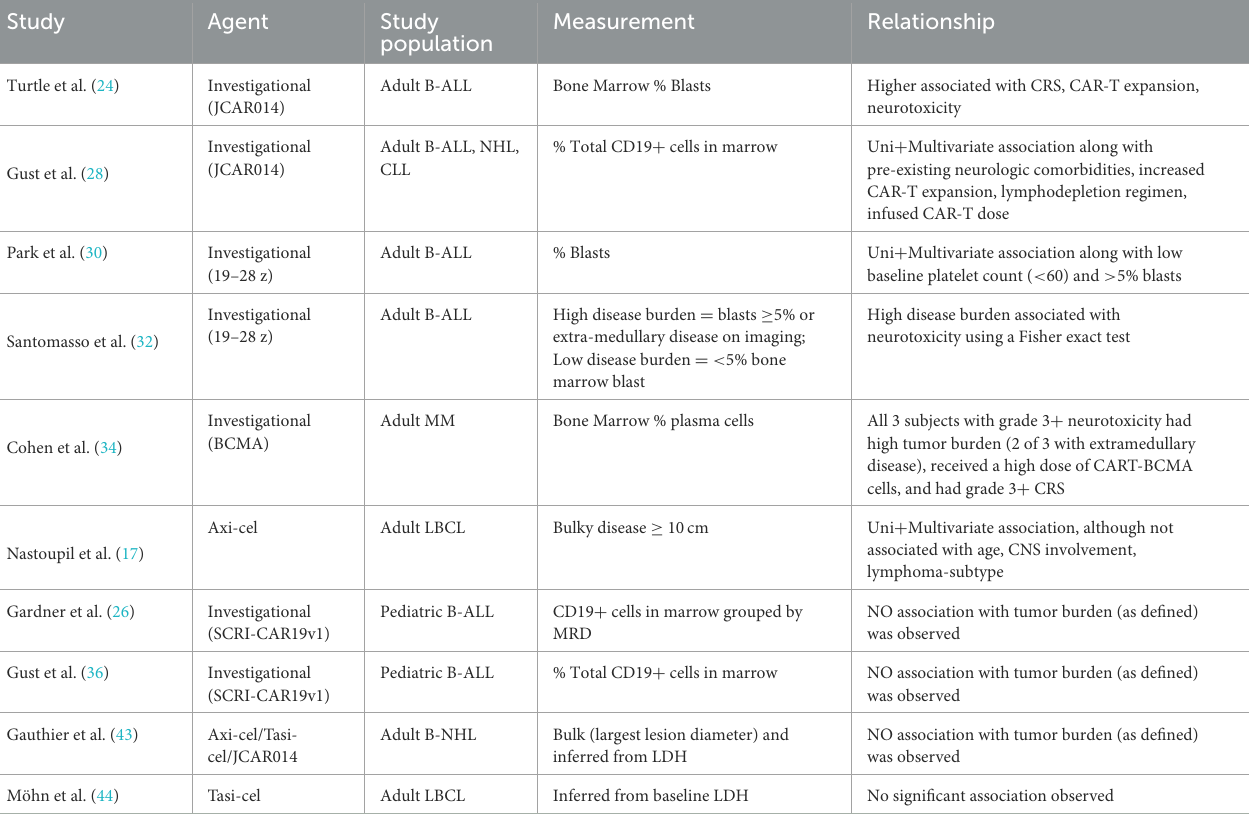
Measurement Relationship population Higher associated with CRS, CAR-T expansion, neurotoxicity Uni + Multivariate association along with pre-existing neurologic comorbidities, increased CAR-T expansion, lymphodepletion regimen, infused CAR-T dose